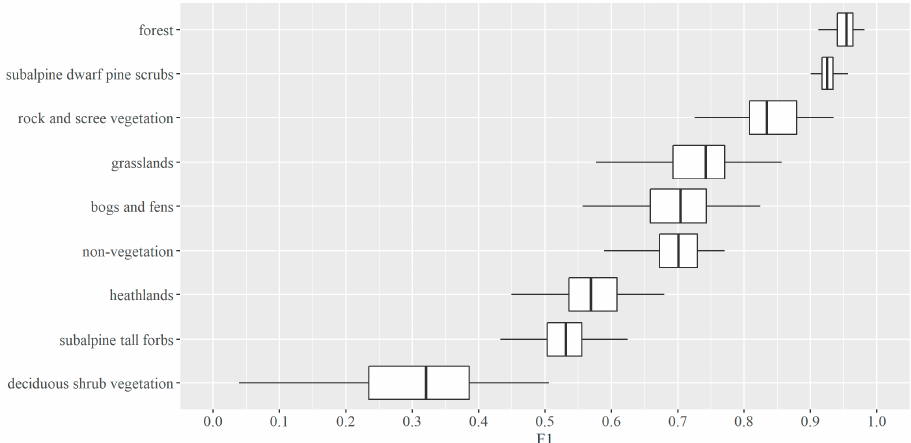
Figure 5. F1 accuracy obtained during the 100-times iterative procedure of accuracy assessment for the best dataset. Table 4. Error matrix generated for the ABC dataset (based on iteration with OA closest to the median; SDPS—subalpine dwarf pine scrubs; F—forest; G—grasslands; NV—non-vegetation; BF—bogs and fens; RSV—rock and scree vegetation; DSV—deciduous shrub vegetation; STF—subalpine tall forbs;